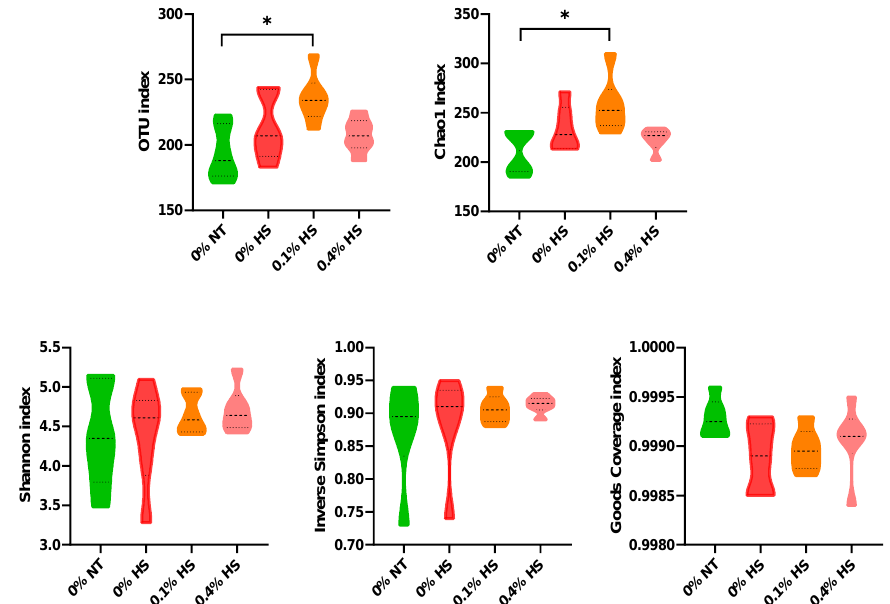
Figure 2. Effects of supplementing diets with solubles from shredded, steam-exploded pine particles (SSPPs) on the alpha-diversity (community richness and diversity) of cecum microflora in broiler chickens exposed to either thermoneutral or heat-stress conditions. Chickens were fed with diets containing 0% (control), 0.1%, and 0.4% SSPPs from the 8th day to the 36th day of age. On the 37th day, birds were either kept at thermoneutral temperature (21.0 °C) and provided a control diet (0% NT) or heat-stressed at 31.0 °C for six hours and provided a diet supplemented with 0% (0% HS), 0.1% (0.1% HS) or 0.4% (0.4% HS) SSPPs. Number of samples in treatment (n = 6). Abbreviations: OTUs, operational taxonomic unit; NT, normal temperature; HS, heat stress. *, significant difference at p < 0.05.